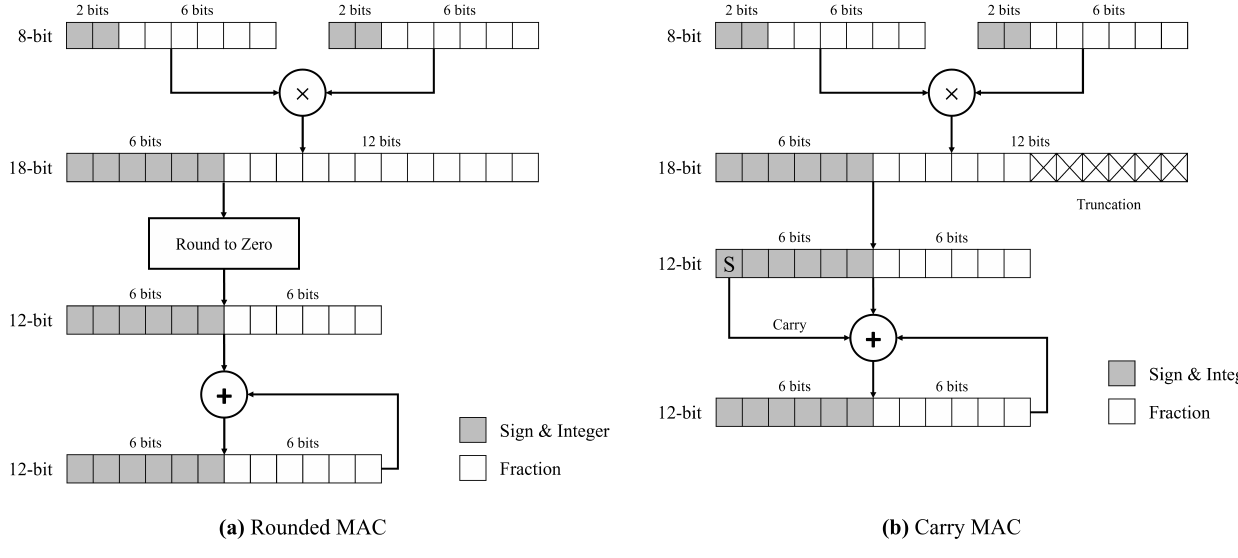
Figure 13. Proposed approximate MAC units: ( a ) rounded MAC and ( b ) carry MAC. The rounded MAC module uses a round-to-zero quantization method for the fixed- point data type. As shown in Figure 14, the truncation of fixed-point data results in data rounded to the floor (minus infinity). Our experiments revealed that simply truncating the lower six fractional bits results in critically reduced classification accuracy. Therefore, a round-to-zero operation is applied to make the rounded value symmetrical for positive and negative values. This process is automatically synthesized as a hardware function, as defined by the HLS tools.